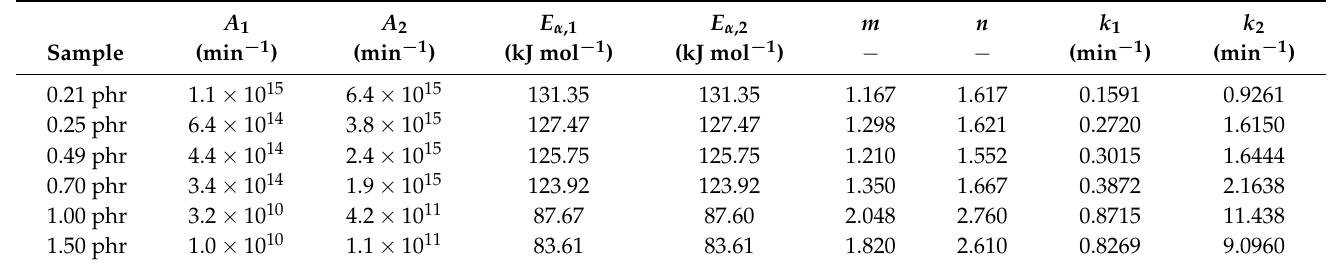
Figure 4. Friedman-like isoconversional approach for calculating the activation energy, regarding the sample 0.21 phr ( a ) and the activation energy for different dicumyperoxide concentration as function of conversion ( b ). Table 3. Kinetic parameters determined after fitting of the experimental conversion rate d α Kamal model (Equation (10)) for silicone rubber compounds crosslinked at 160 ◦ C with different dicumylperoxide